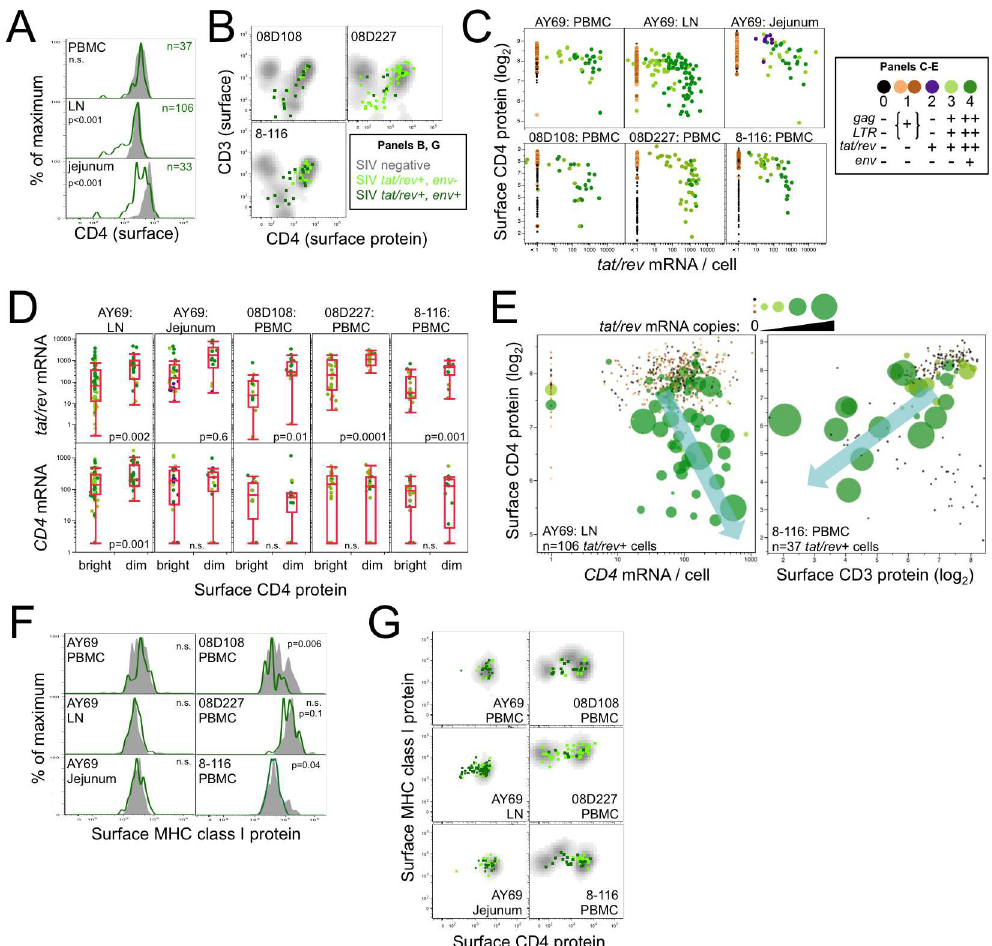
Fig 3. Post-transcriptional CD4 downregulation and MHC class I preservation on in vivo infected T cells. (A) FACS stainingdistributionof surface CD4 protein on SIV tat/rev + productively infected (green; n = number of cells analyzed)memory CD95 + CD4 T cells from animal AY69 PBMC, lymph node, and jejunumcomparedto uninfectedcells (gray). (B) FACS surface staining for CD3 and CD4 on tat/rev + cells from memory CD3 +/- CD4 T cells in PBMC from 3 additional animals. (C) FACS CD4 surface fluorescence is plotted against tat/rev mRNA copies. Dot colors correspondto Fig 1F. (D) tat/rev (top) and CD4 (bottom) mRNA copies per tat/rev + cell is plotted by surface CD4 protein expression. (E) Surface CD4 protein (fluorescence) is plotted against CD4 mRNA (left) or surface CD3 protein (right). Dot size correspondsto tat/rev mRNA copies per cell. FACS surface stainingof surface MHC class I (F) and co-expression with surface CD4 (G) on tat/rev + cells. Experiments were performed once for each specimen and all data is